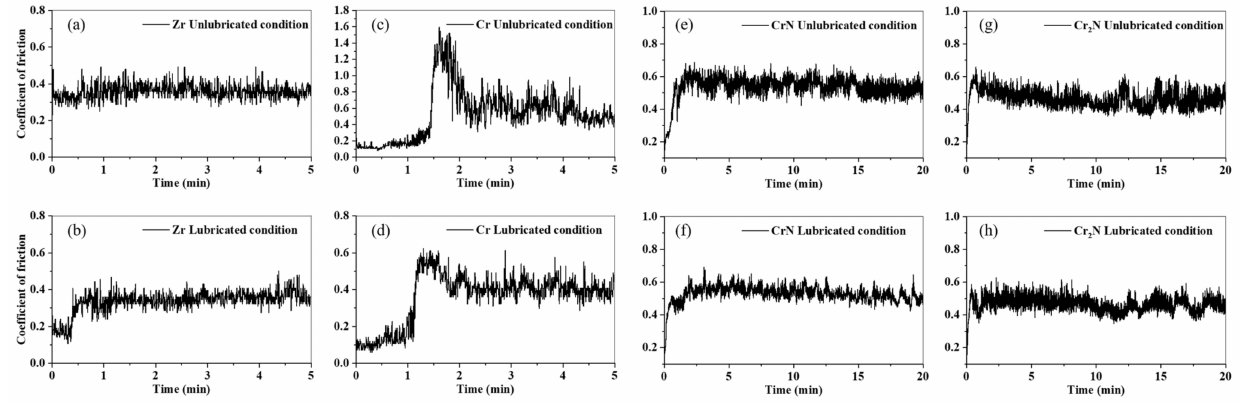
Figure 11. Coefficients of friction of ( a , b ) Zr-4 alloy and ( c , d ) Cr coating under 1 N and 5 min of load time, in addition to the ( e , f ) CrN and ( g , h ) Cr 2 N coatings under 10 N and 20 min load time under unlubricated and water-lubricated